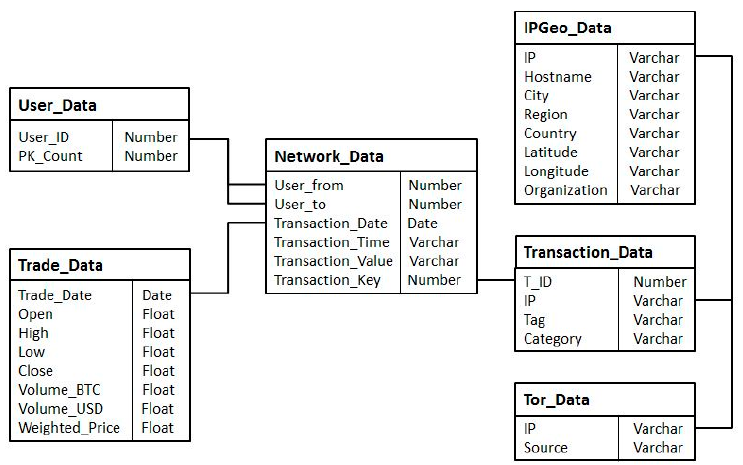
Figure 5. Final Data Model.